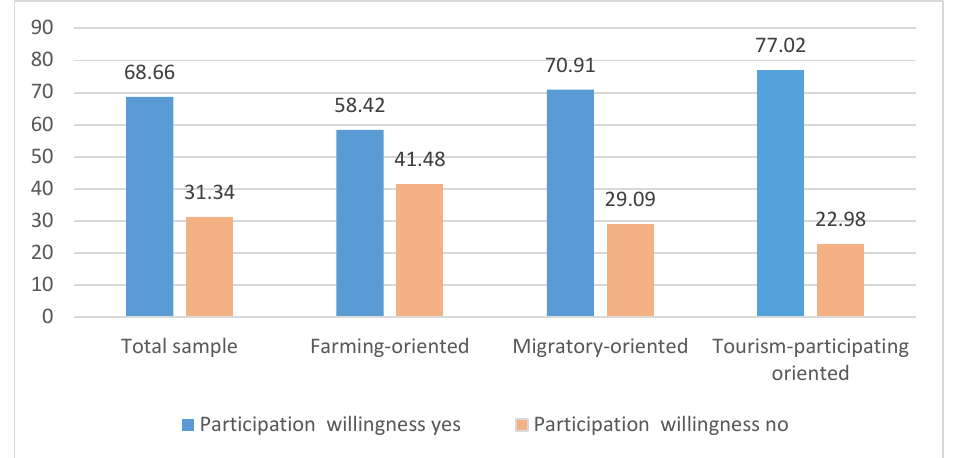
Figure 2. Distribution of rural households’ willingness to participate in rural tourism in surveyed areas (%)